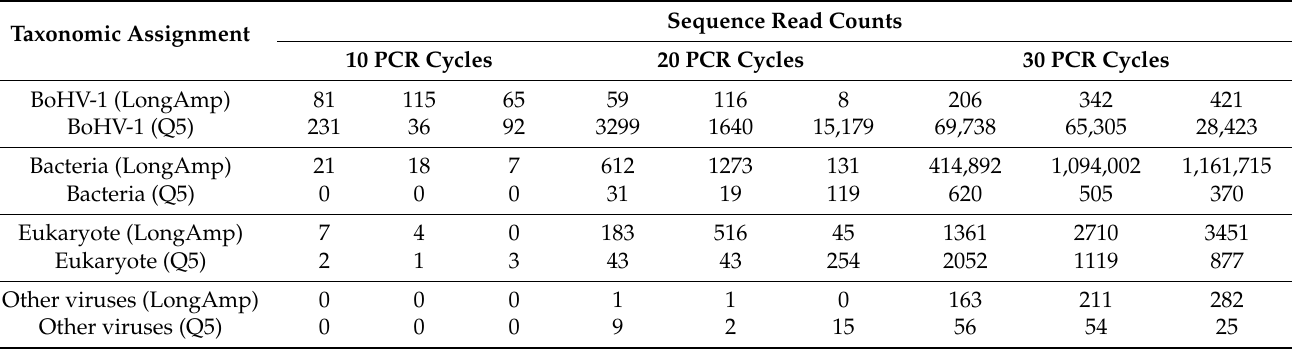
Table 3. Comparison of PCR polymerase bias on BoHV-1 detection sensitivity in MinION sequenc- ing